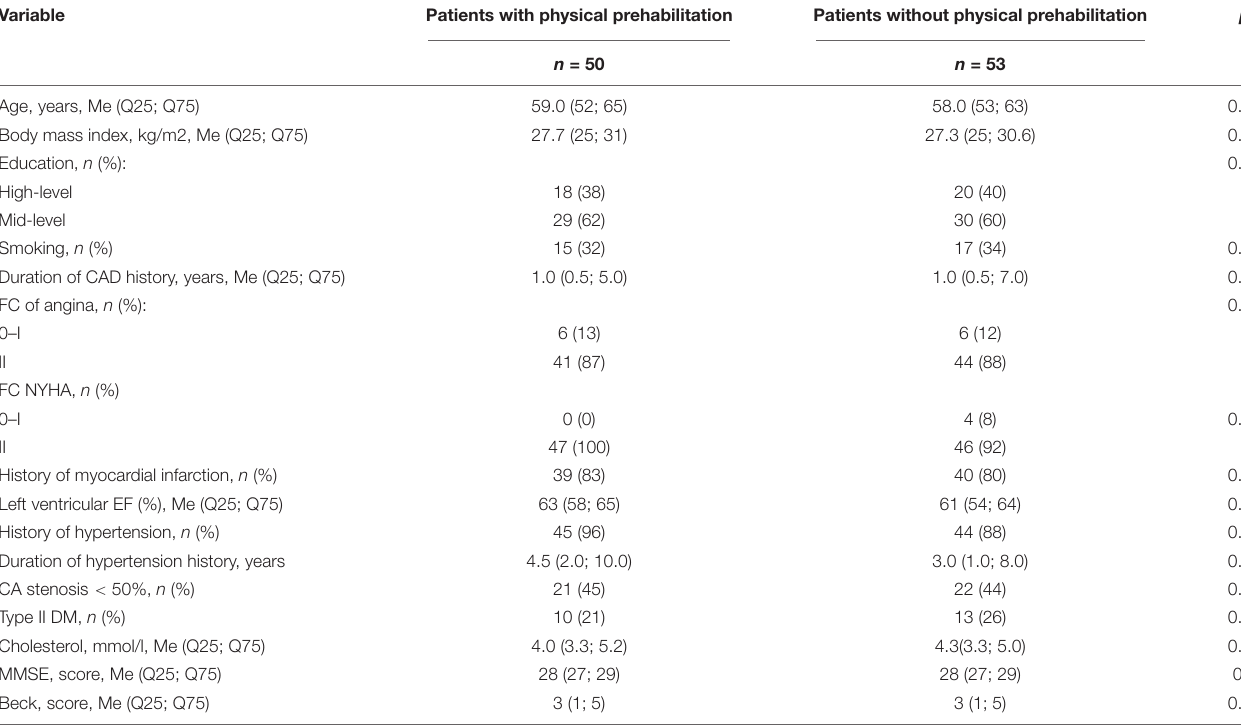
TABLE 1 | Clinical and demographic characteristics of coronary artery bypass grafting (CABG) patients who did and did not undergo a course of physical prehabilitation. Variable Patients with physical prehabilitation Patients without physical